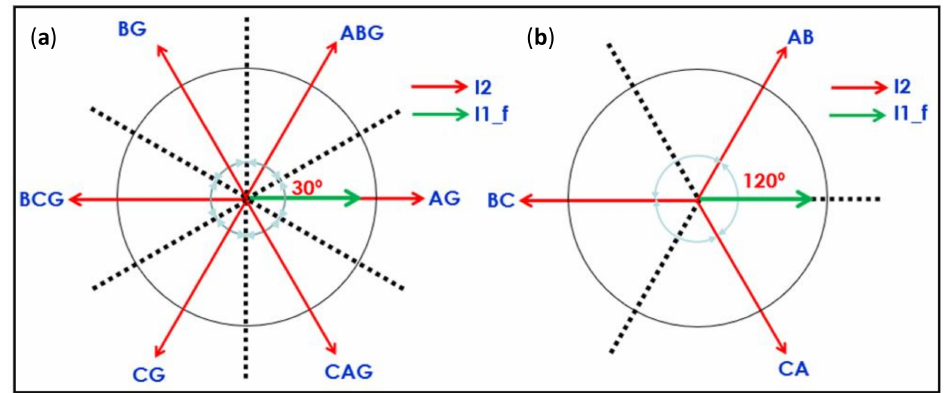
Figure 1. Angular relationship between the negative current ( I2 ) and the pure positive sequence current ( I1_f ): ( a ) Single-phase- and two-phase-to-ground fault diagram; ( b ) two-phase fault dia- gram